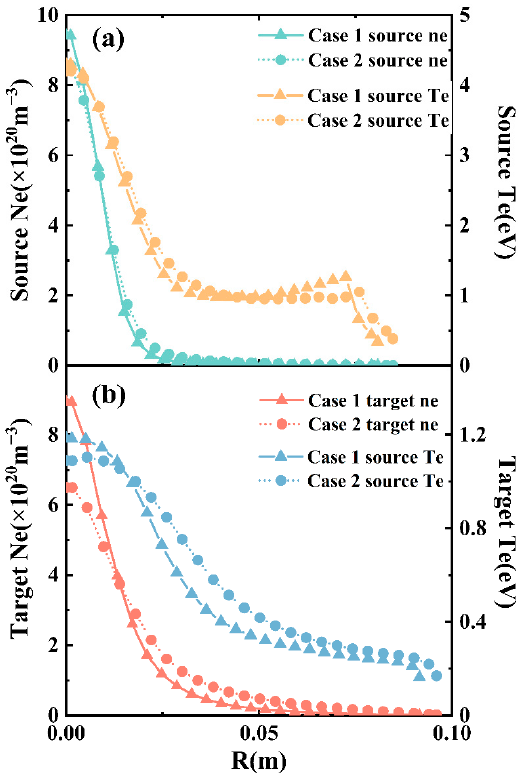
Figure 15. The electron density/temperature radial distributions at the source ( a ) and target ( b ) lo- ( b ) locations in the two cations in the two case s .